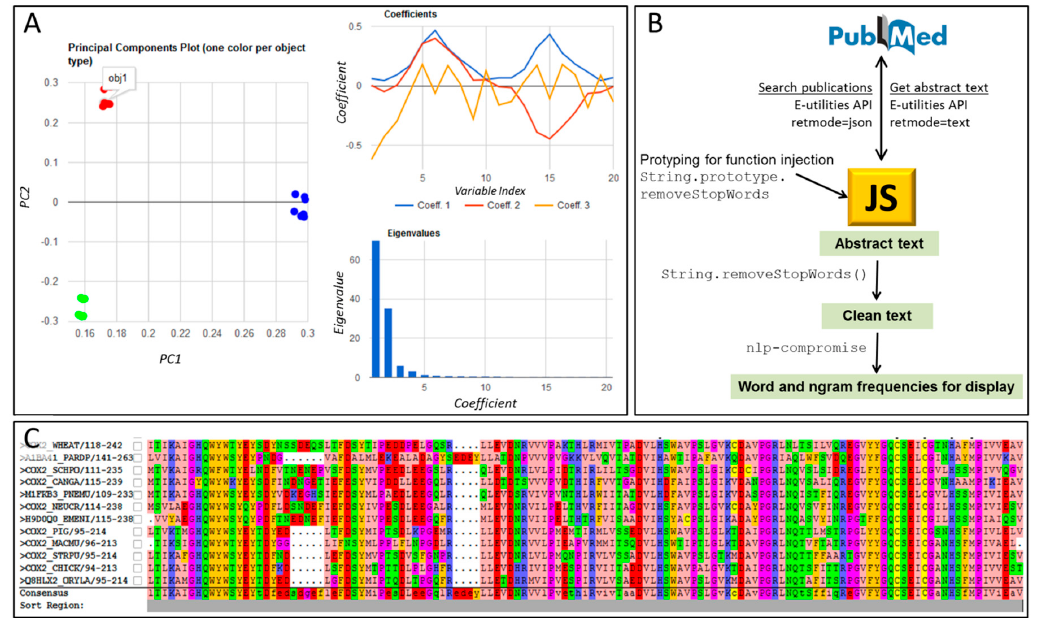
Figure 2. Tools for data analysis and visualization. ( A ) Outputs from the tool for principal component analysis (https://lucianoabriata.altervista.org/jsinscience/pca/pca3.html) run on a collection of 21 objects of three types, each described by 20 variables. Singular value decomposition of the 21 × 20 matrix is performed with LALOLib. Google Charts is used to display a scatter plot of the 21 objects mapped on the two first principal components, line plots of the contribution of each variable to each principal component, and bar plots of the eigenvalues to measure the fraction of variability explained by each principal component; ( B ) Diagram depicting how to search, retrieve and analyze PubMed abstracts with JavaScript (https://lucianoabriata.altervista.org/jsinscience/texts/textworks.html). A query through Eutils API retrieves articles in JSON format; then, further calls retrieve their texts. Abstract texts are processed with a function prototyped into the Script class, which removes stop words (these are irrelevant words that would confound further